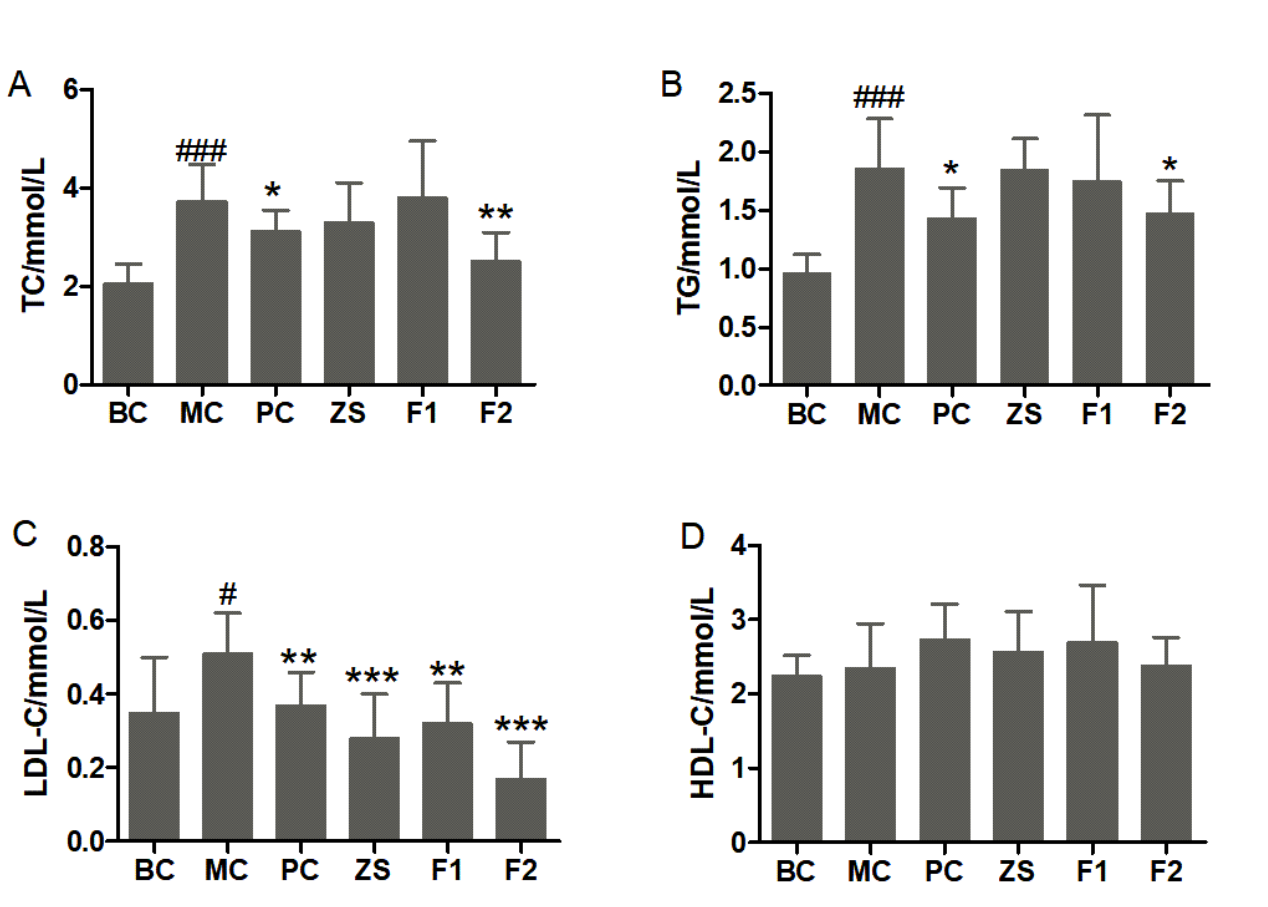
FIGURE 1 - Effect of BCLE on lipid levels in KK-A y mice (data are expressed as means ± SD) (A)TC; (B)TG; (C)LDL-c;